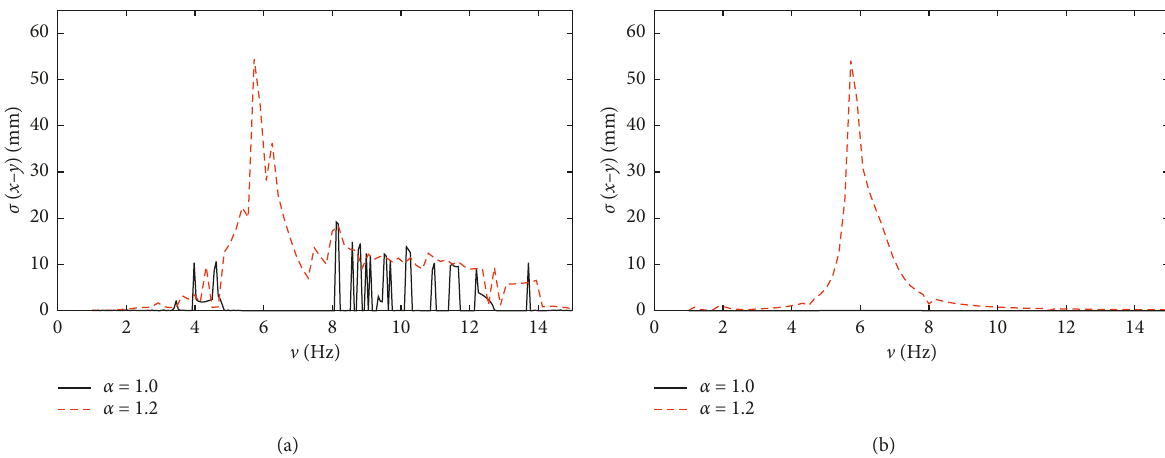
Figure 10: The relative displacements x − y of the oscillators in terms of the standard deviation σ ( x − y ) for R � 300k Ω and δ Δ � 5 mm; (b) Δ � 15 mm (the line for α � 1.0 is on the x-